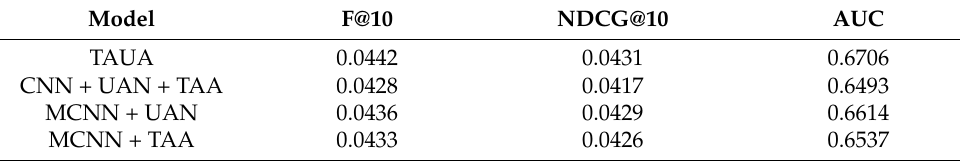
Table 12. Performance ablation of TAUA in Flickr dataset.